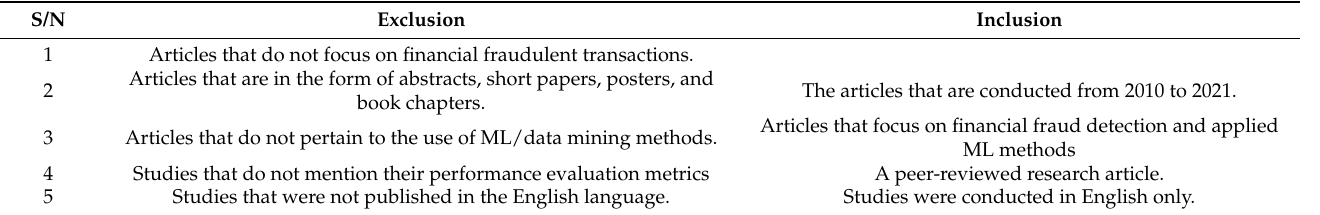
Table 2. Exclusion and inclusion criteria.